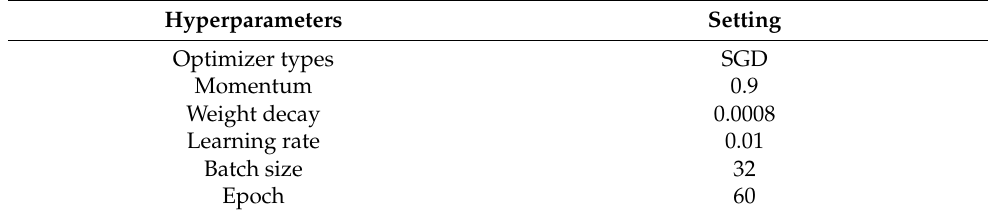
Table 2. Hyperparameter settings for model